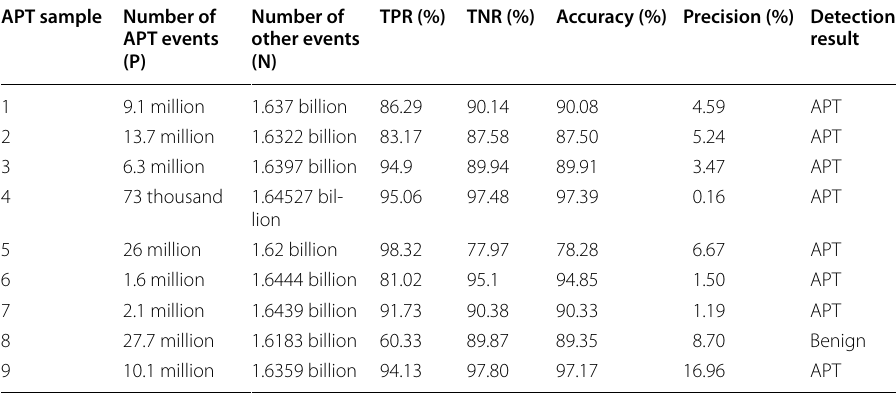
Table 13 Results of evaluation per each APT sample of Table 11 APT sample Number of APT events